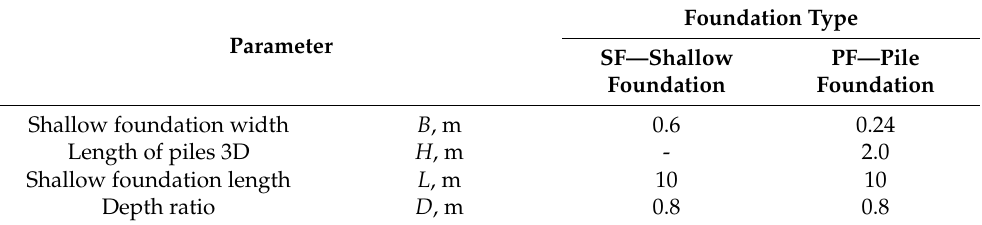
Table 6. The geometry of the analysed shallow SF and pile PF foundations.